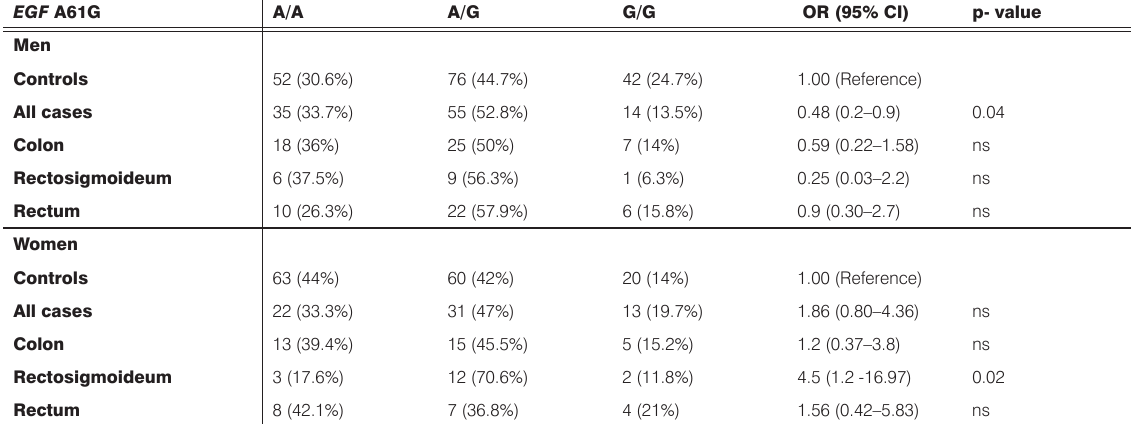
Table 5. Frequency distribution of EGF A61G polymorphism between cases and controls and its association with risk of colorectal cancer or selected diagnosis. EGF